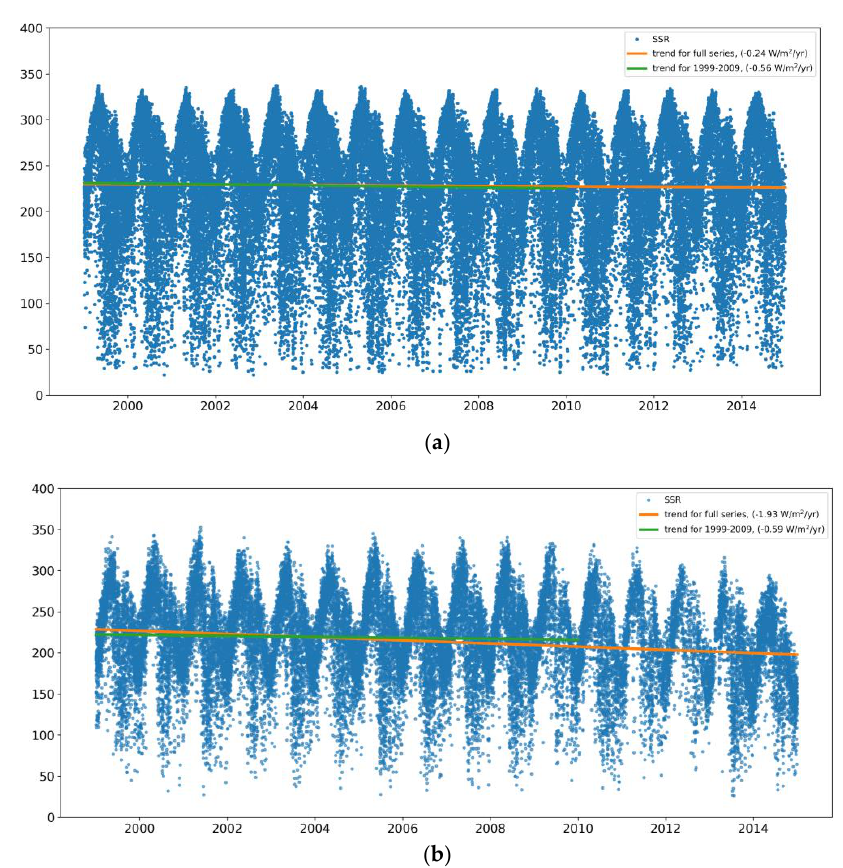
Figure 5. Daily mean SSR trends for 1999–2009 (green) and 1999–2014 (orange): ( a ) from the SARAH-E time series; and ( b ) from IMD in situ measurements. Blue markers indicate available SSR data.